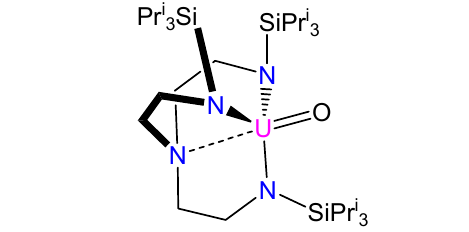
Figure 6. The mononuclear uranium(V) U(Tren TIPS )(=O) SMM [127].